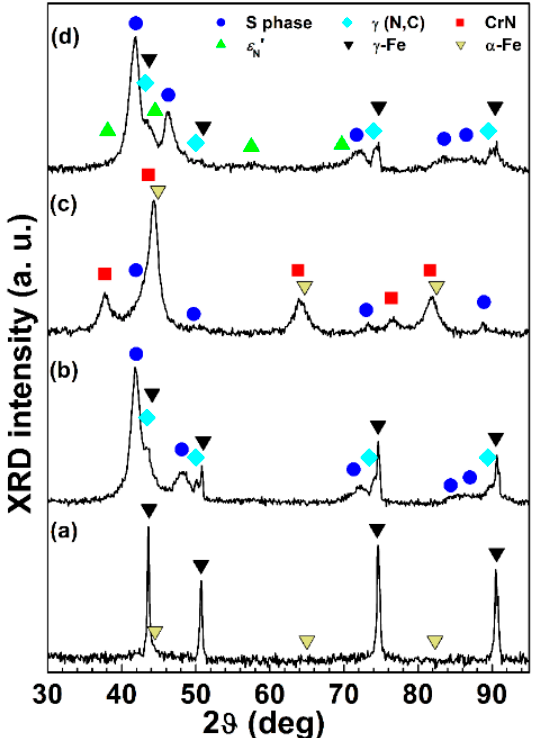
Figure 4. X-ray diffraction patterns of samples untreated ( a ) and Type-A ( b ), Type-B ( c ) and Type-C ( d ) treated.